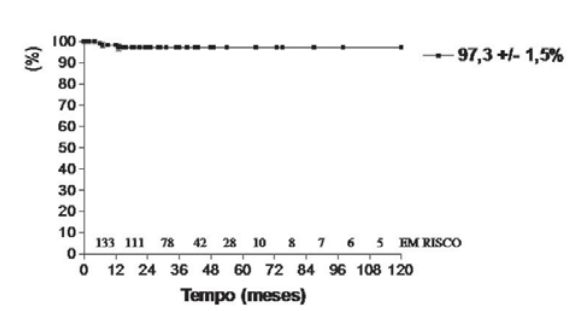
Fig. 3 - Curva atuarial livre de tromboembolismo